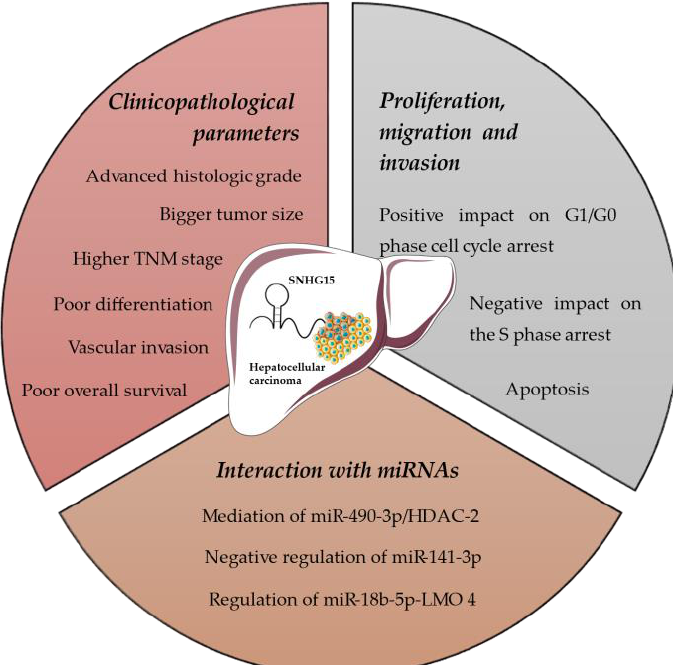
Figure 2. Effects of SNHG15 on hepatocellular carcinoma.